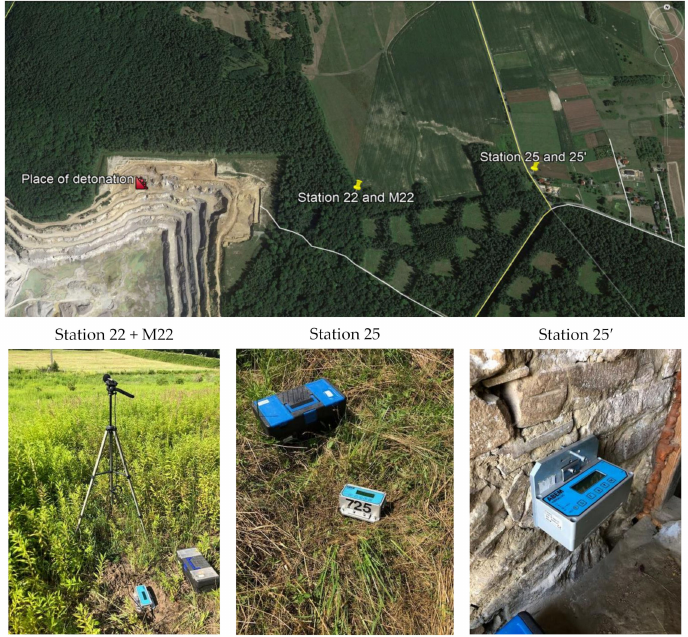
Figure 5. Blasting site and measurement